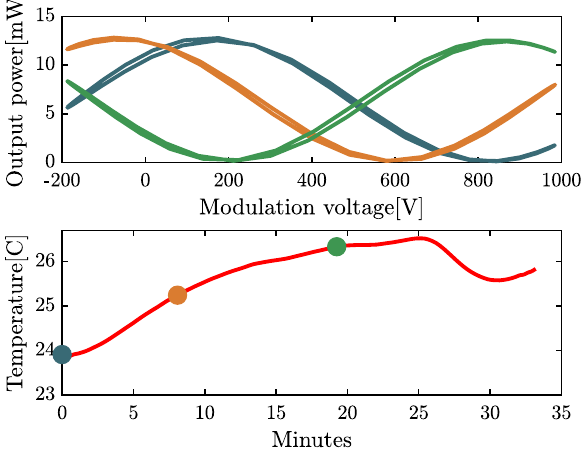
Figure 23. Shift of the transfer function due to decreasing